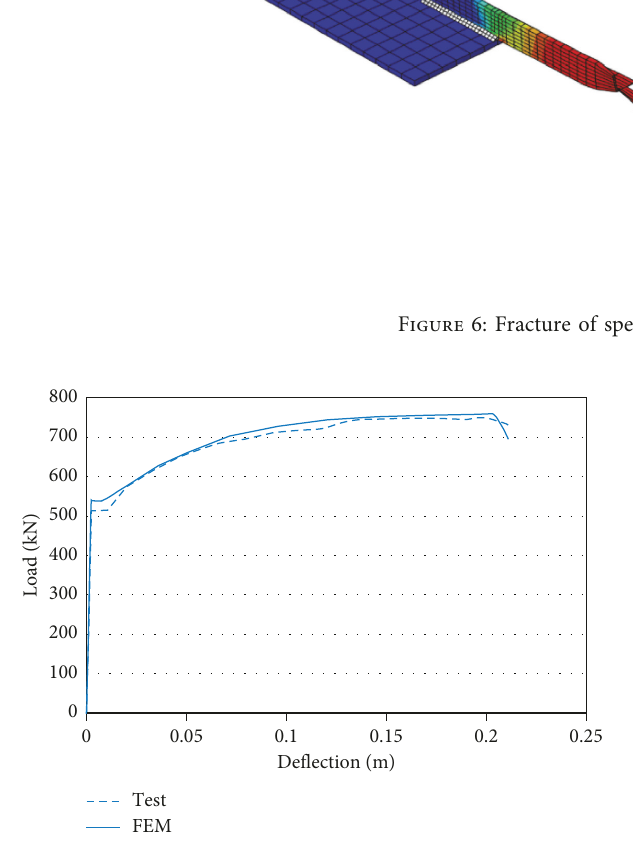
Figure 7: Comparison of load- deflection curves obtained from the test and FE model for specimen 1.